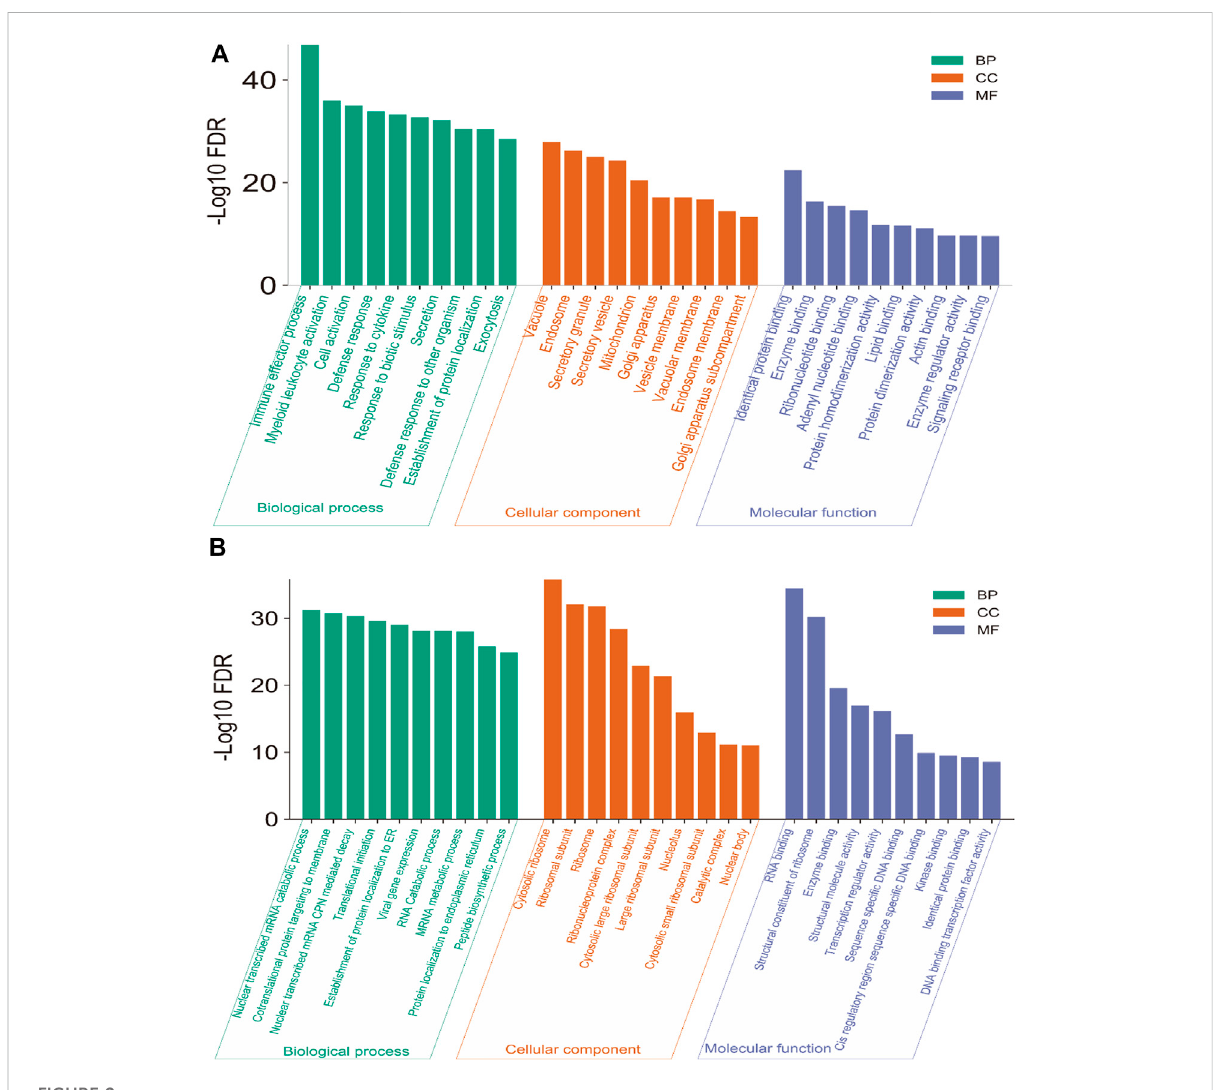
FIGURE 2 Signi fi cantly up-regulated (A) and down-regulated (B) GO in the blood of